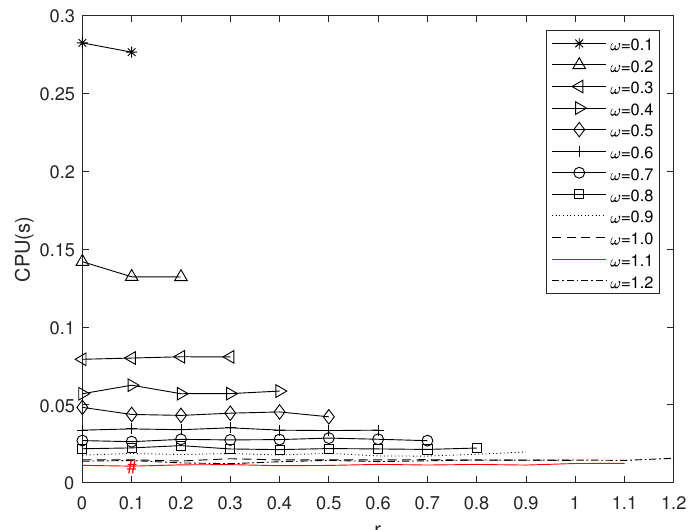
Figure 1. The numerical results of Example